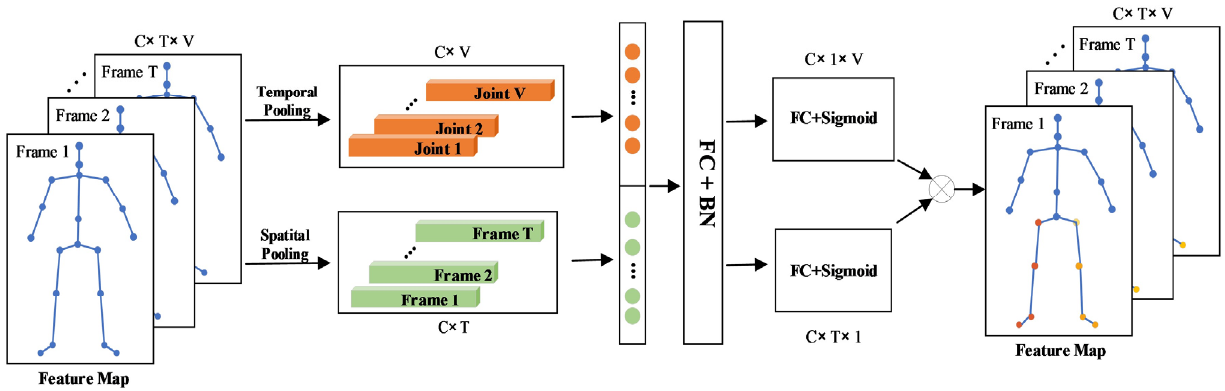
Figure 3. ST-JointA tt model structure. Figure 3. ST-JointAtt model